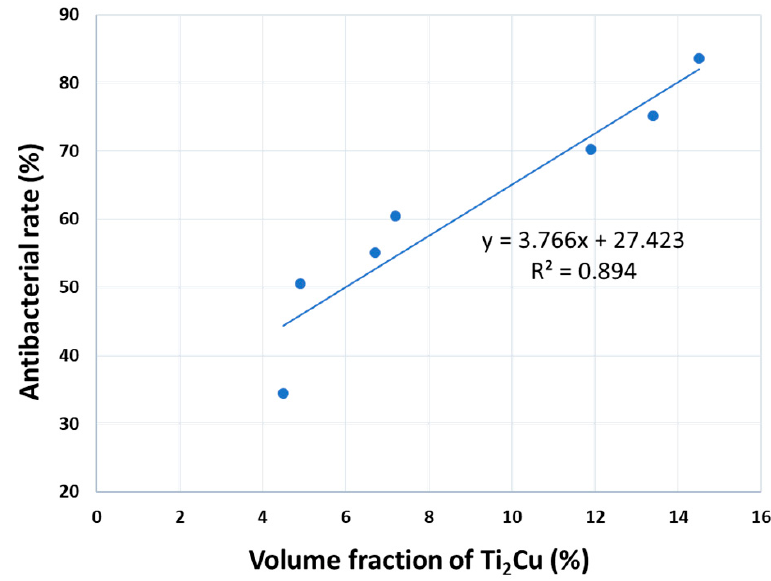
Figure 9. Antibacterial rate versus volume fraction of the Ti 2 Cu and Cu-rich phases.